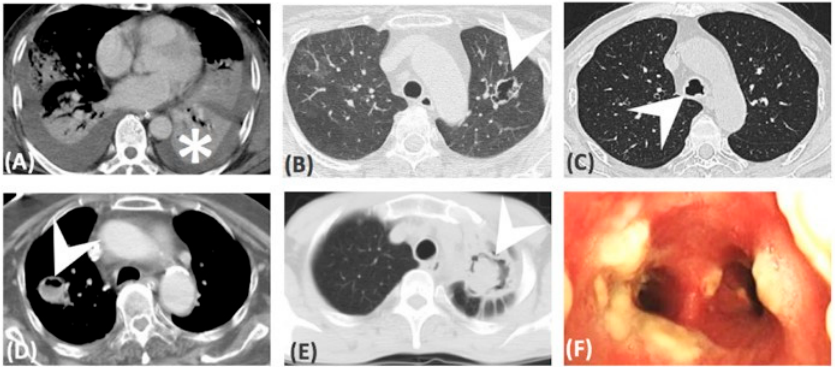
Figure 3. CT images: ( A ) Consolidation, ( B ) cavitation, ( D ) abscess formation, ( E ) ball in hole, ( C,F ) airway involvement only.